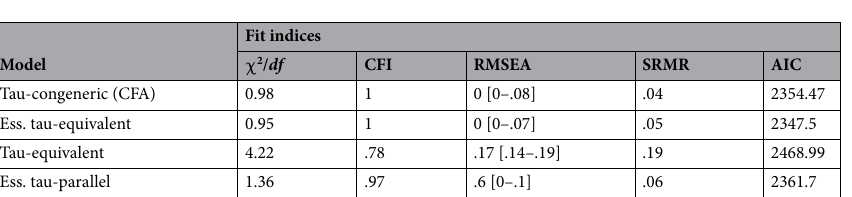
Table 8. Fit indices for different measurement models. CFA = confirmatory factor analysis; Ess. = essential; CFI = comparative fit index; RMSEA = root-mean-square error of approximation (with 90% confidence